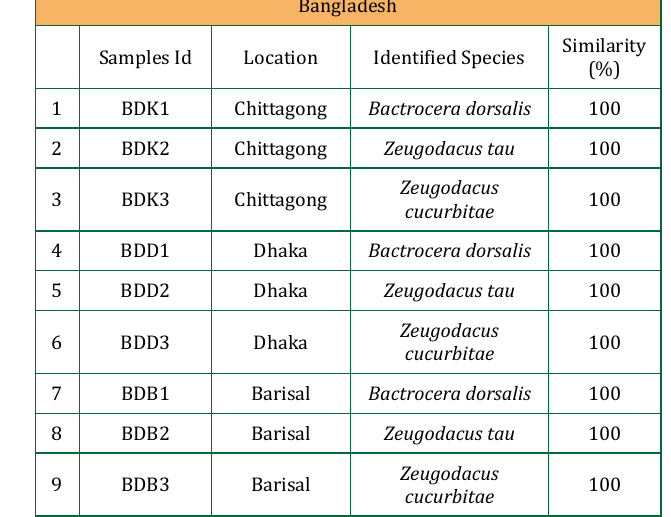
Figure 3: Neighbor Joining (NJ) tree developed from COI barcoding analysis showing the phylogenetic position of 9 fruit fly species B. dorsalis , Z. cucurbitae , Z. tau and Anastrepha frateculus . Anastrepha frateculus was out of the group. Percent bootstrap value of 1000